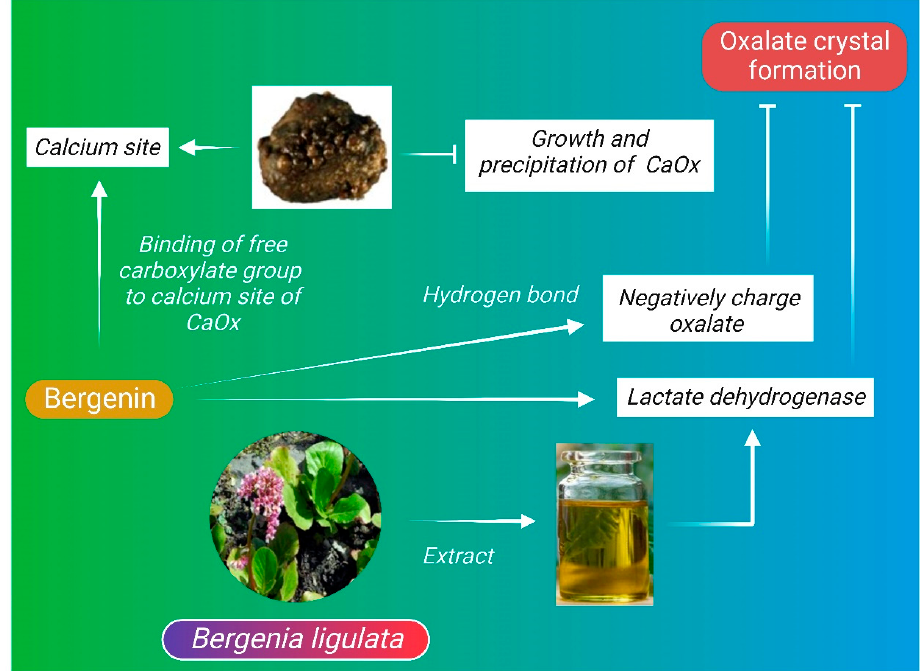
Figure 2. Anti-urolithiatic mechanism of B. ligulata . Bergenin, one of the bioactive components of B. ligulata, makes it a potent anti-lithiatic herb. Hydrolysis product of bergenin, i.e., 4-O- methylglycoside (4-OMG), has negatively charged free carboxylate group, which enables it to bind with the calcium site of calcium oxalate (CaOx) crystals and inhibit the precipitation of these crystals, thereby impeding renal stone